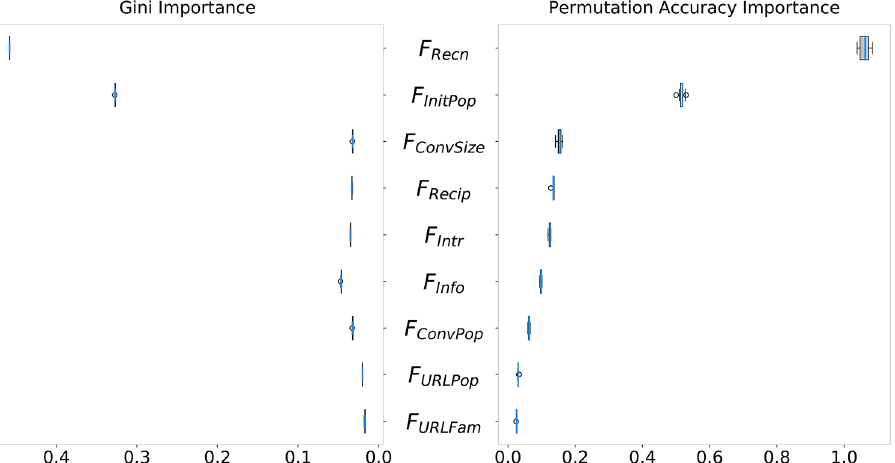
Figure 4. Gini and Permutation Accuracy importance of factors hypothesized to drive response prioritization under information overload. F Recn is by far the most important factor for response prioritization, more than twice as more important than the second most important factor, F InitPop . The rest of the factors are ordered in descending order of importance as follows: F Info , F Intr , F Recip , F ConvPop , F URLPop , F ConvSize , F URLFam .